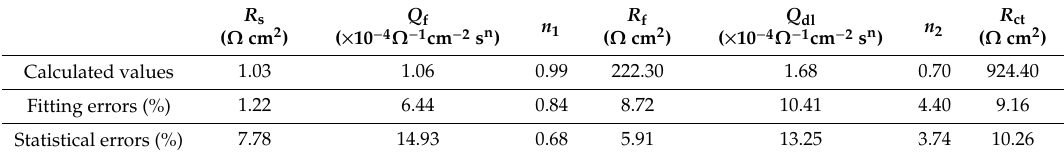
Table 2. Fitted parameters for the EIS of the electrode after corrosion under static-state conditions.